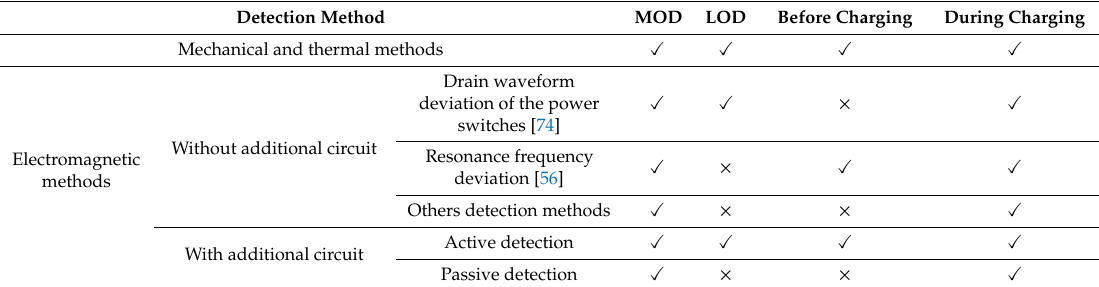
Table 4. Suitable foreign object types and operating times of the major FOD